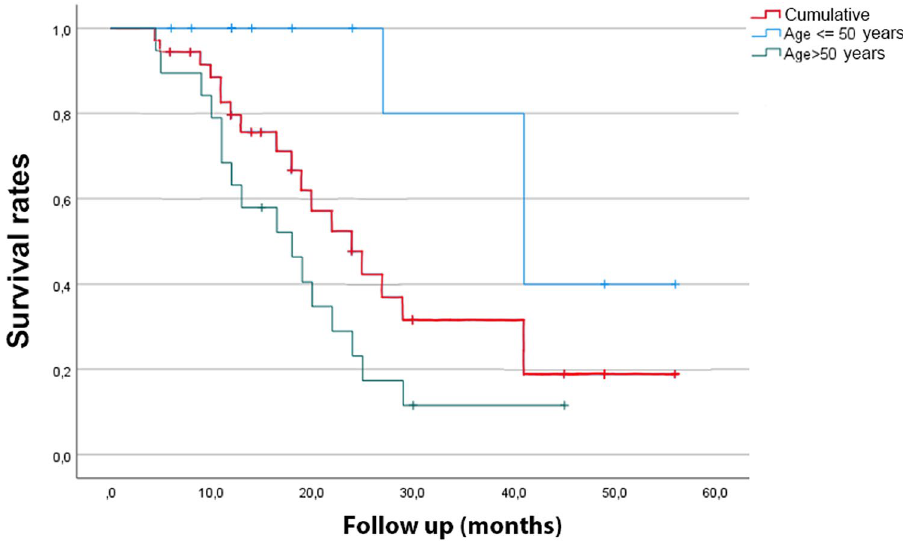
Figure 1. Timing of events, in terms of indication for cataract extraction surgery, over the follow-up period. The figure includes the cumulative curve, and the curves referring to patients aged ≤ 50 and > 50 years.